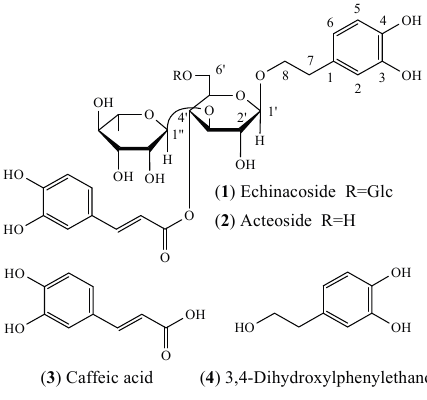
Figure 1. Structures of compounds 1 – 4